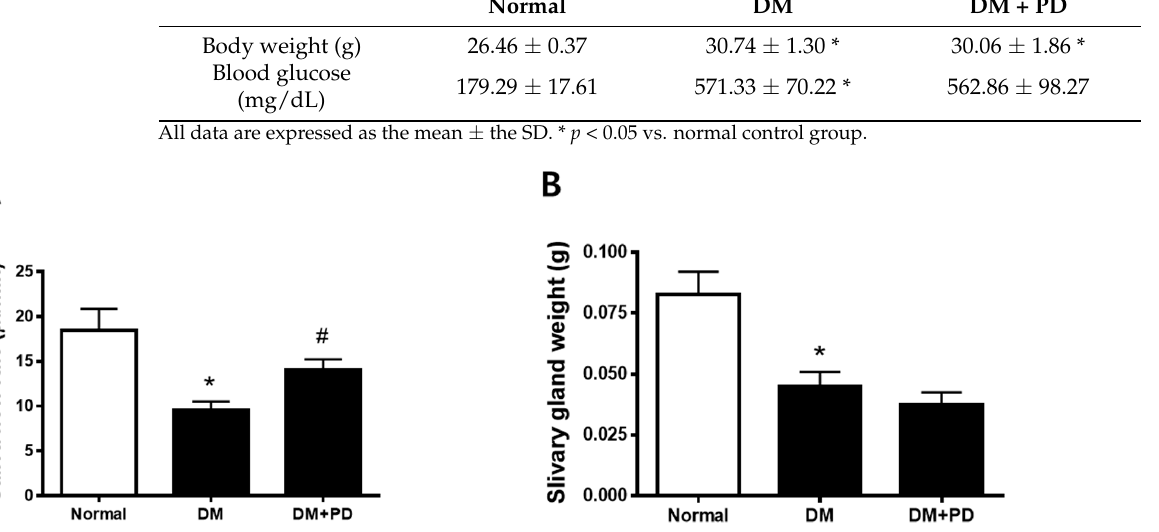
Figure 3. Effect of polydatin on histological changes and apoptosis in submandibular glands. ( A ) Histological analysis of the submandibular gland was performed and images of H&E staining are presented. ( B ) TUNEL staining is presented. Arrows indicate TUNEL-positive cells. Data are pre- sented as the mean ± standard deviation ( n = 7). * p < 0.05 vs. Normal group; # p < 0.05 vs. DM group.